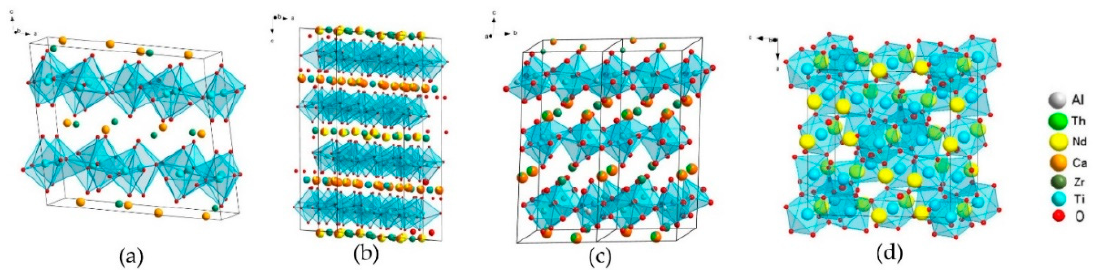
Figure 3. Structure of zirconolite polytypes ( a ) 2M, ( b ) 4M, ( c ) 3T, ( d ) pyrochlore Nd 2 (Ti,Zr) 2 O 7